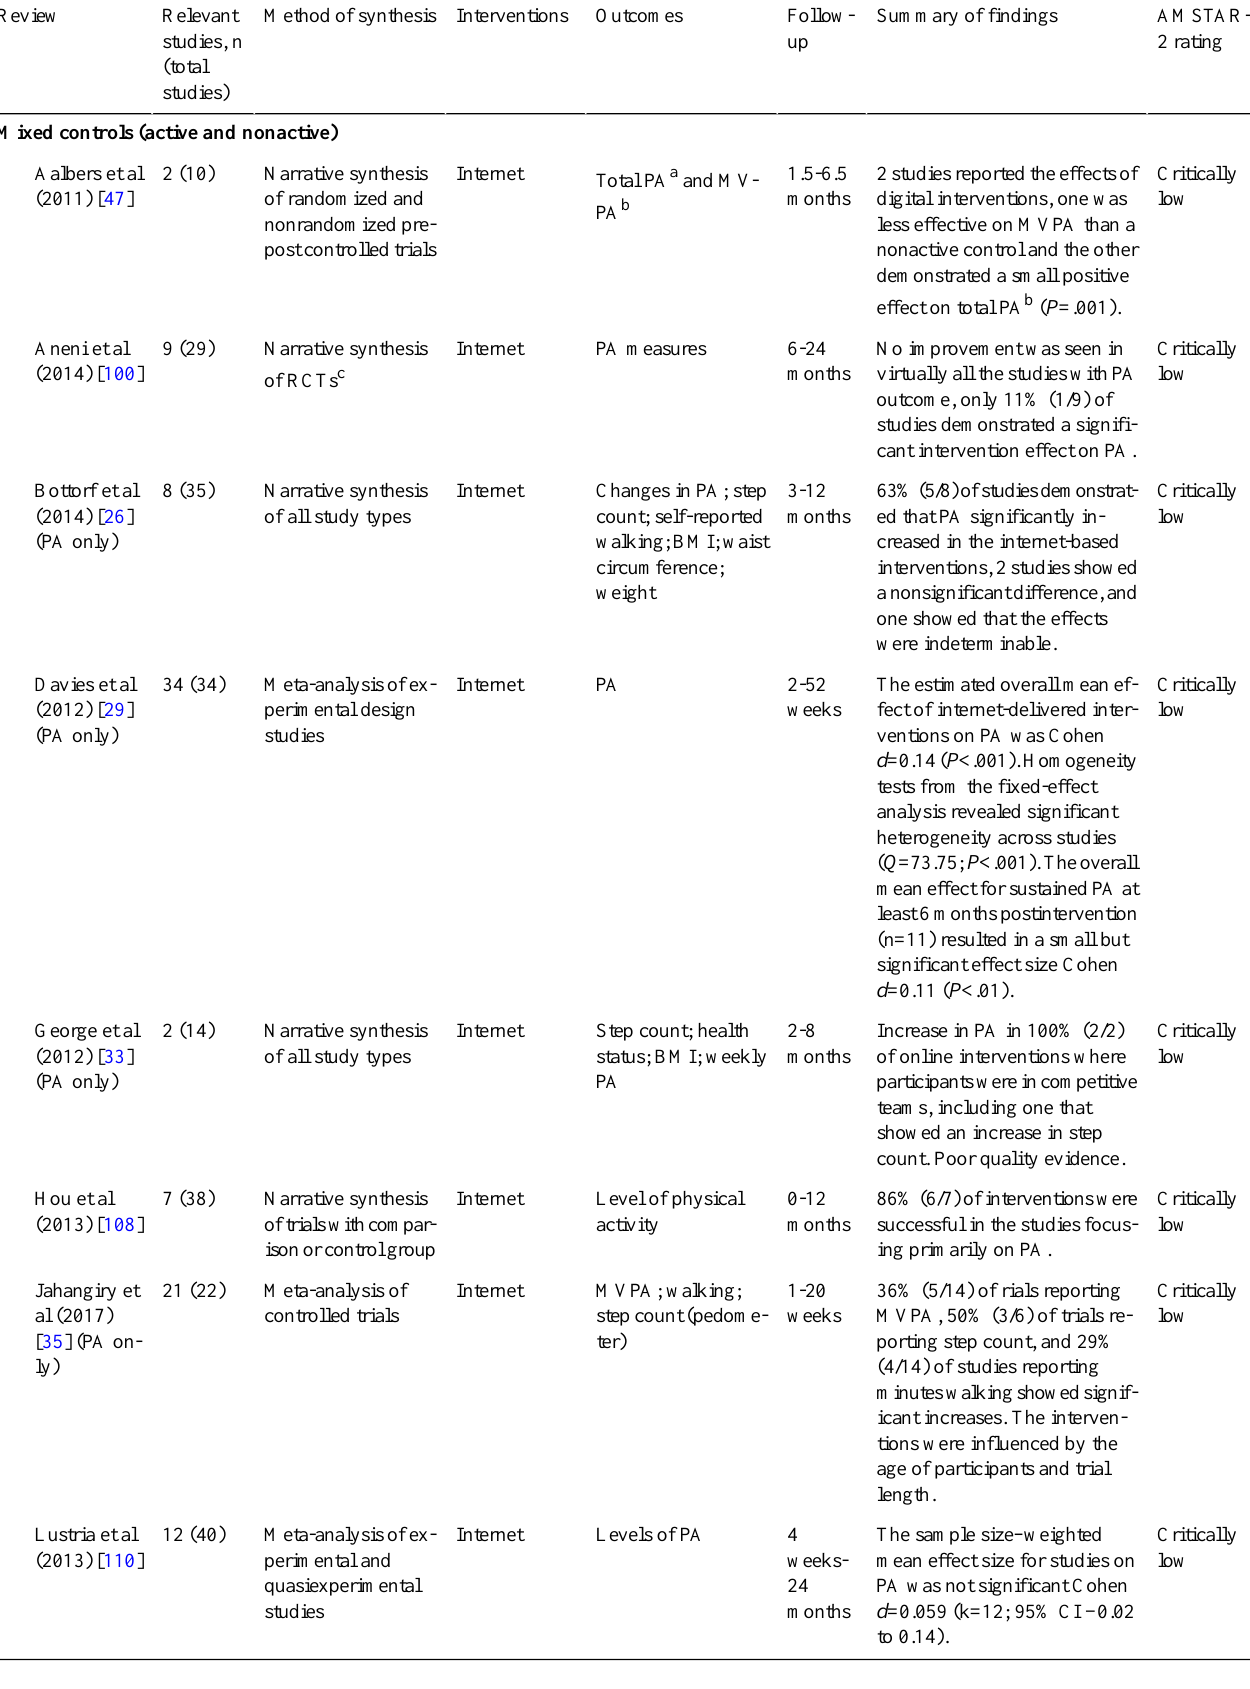
Table 4. Results of reviews on physical activity, ordered by type of control and further ordered by mode of delivery of